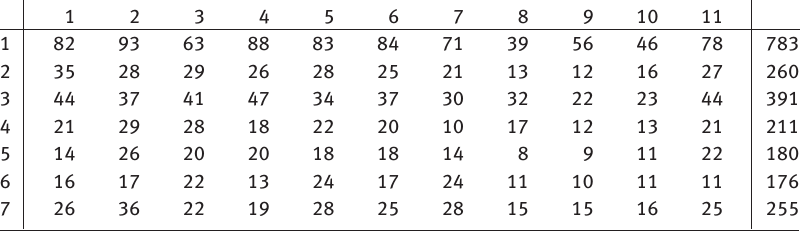
Table 6: Clusters and treatment levels : The rows are the seven clusters and the columns are the eleven treatment levels. Entries are counts of subjects in that cluster given that product.